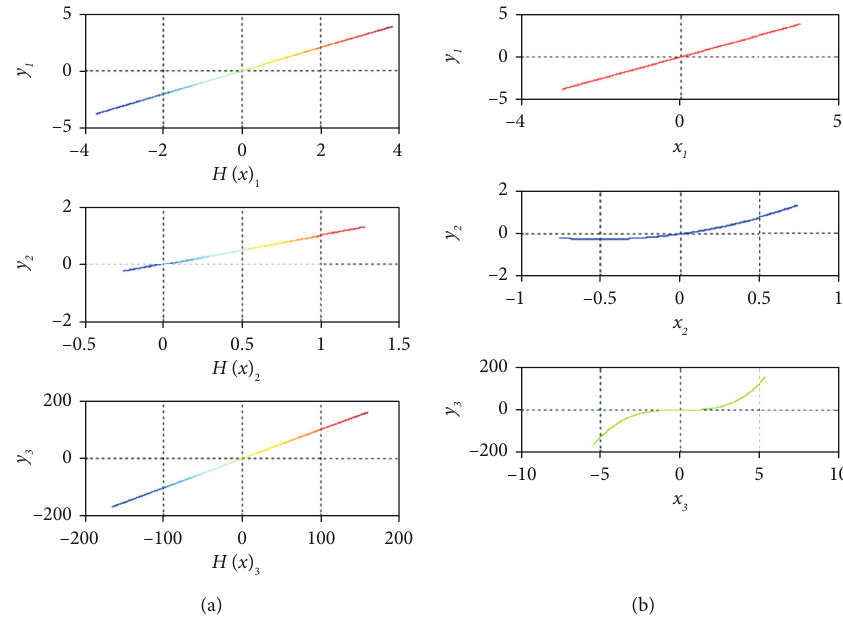
Figure 13: The synchronization relationships of di ff erent state variables in the unidirectionally coupled Chua ’ s circuit. (a) H ð x Þ = ð H ð x Þ Þ T and y = ð y , H ð x Þ , H ð x Þ 1 2 3 synchronization with respect to the high-order polynomial manifold y = ½ x